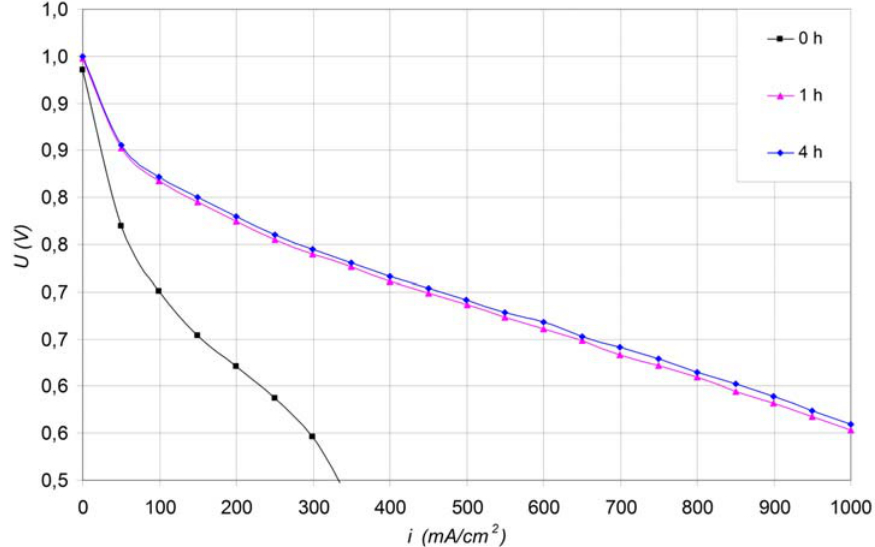
Fig. 3. Polarization curve change for the constant voltage break-in